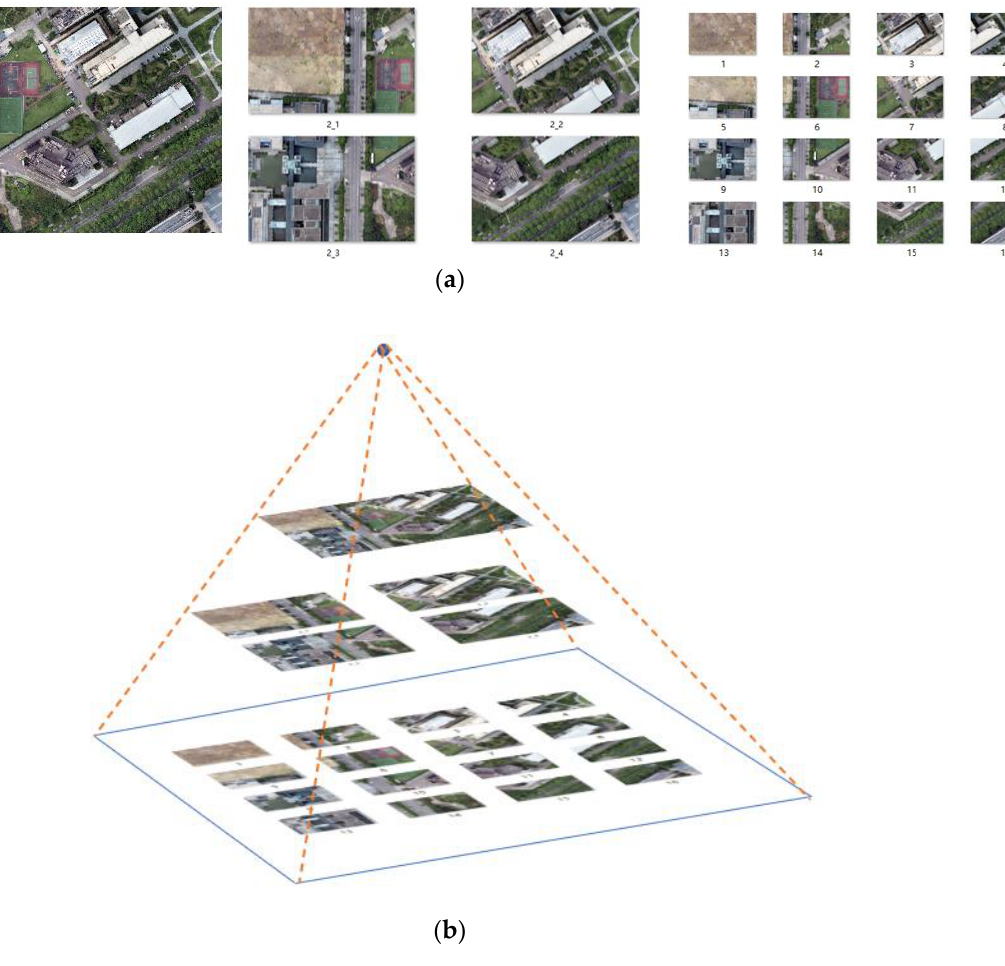
Figure 5. A map with layers and blocks, the numbers in Figure represent the numbers of the map blocks: ( a ) plan diagram ; ( b ) map